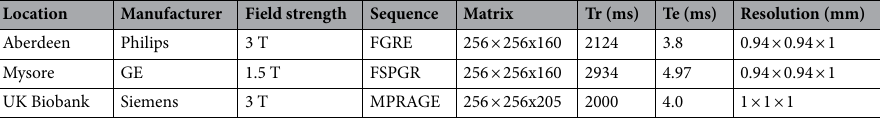
Table 8. MRI data